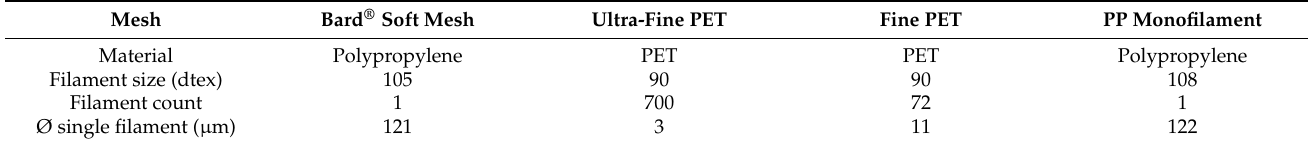
Table 1. Fiber characteristics of various